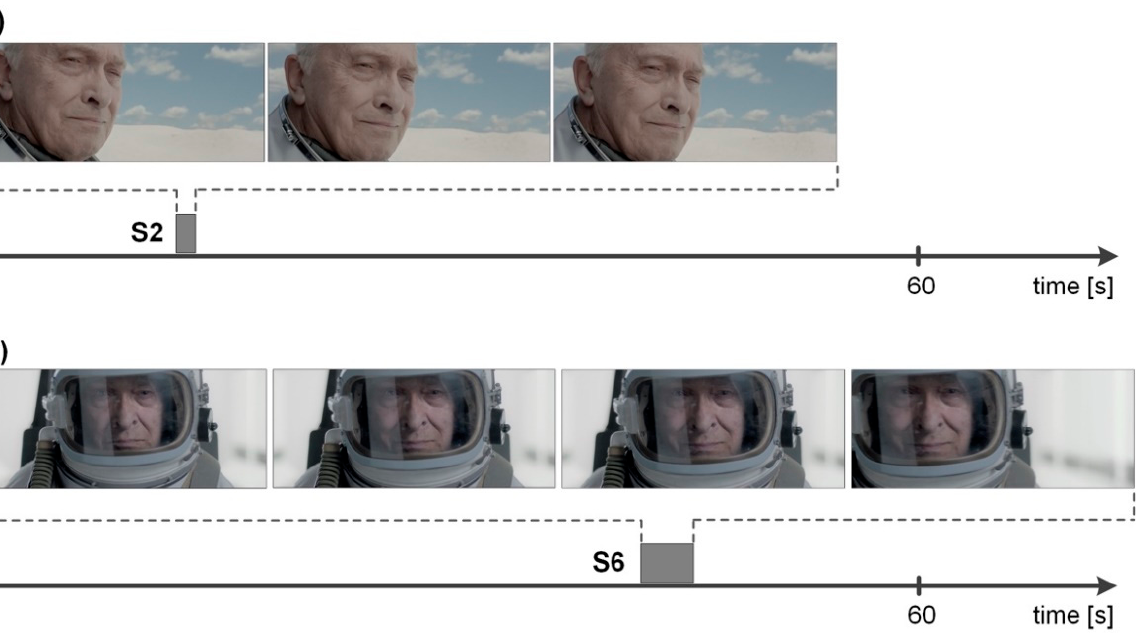
Figure 5. Frames extracted for S7 from advertisement under study. This is the final advertisement part which continues for 12 s and contains information encouraging people to support the construction of an adult hospice. The scene is mono- chrome (black and white). The visual part is complemented by a voiceover that appeals for financial support via the provided website address. Measurements of the electrical activity of the brain have shown that the high EEG temporal resolution makes it possible to examine even the elusive fragments of the mes- sage that last fractions of a second. Many of such stimuli remain beyond the conscience of the recipient. Therefore, it seems almost impossible to express any opinion about such fragments.